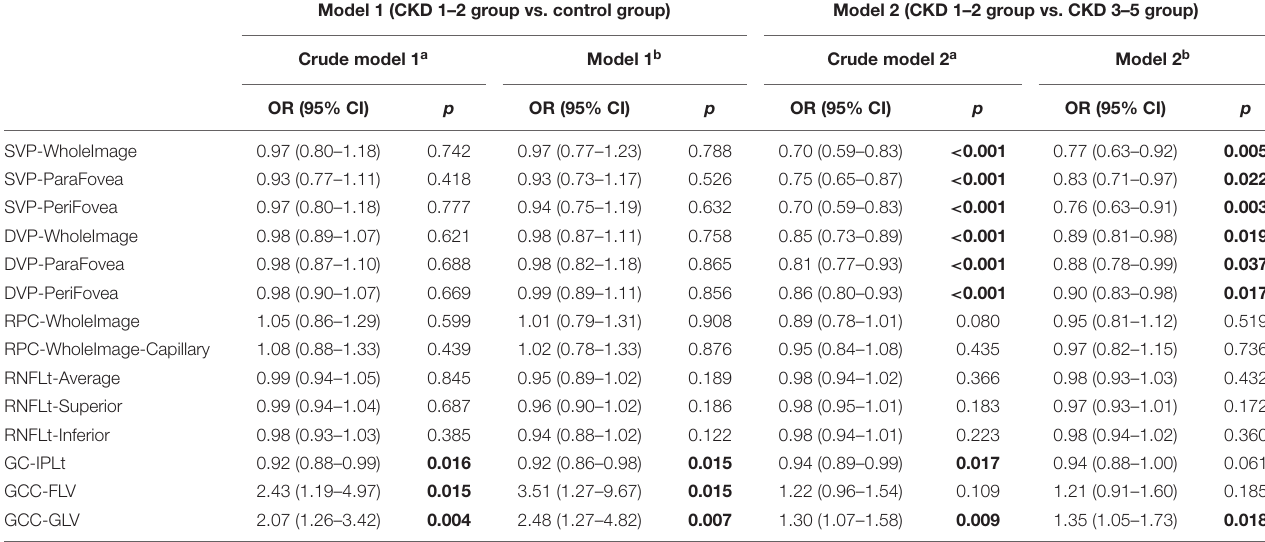
TABLE 3 | Association between OCTA parameters and severity of CKD.